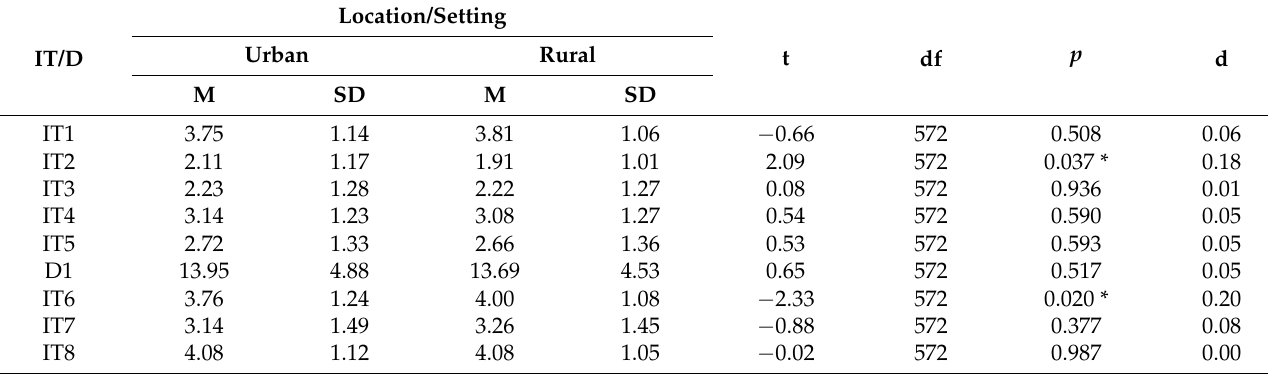
Table 5. T -test based on the variable school